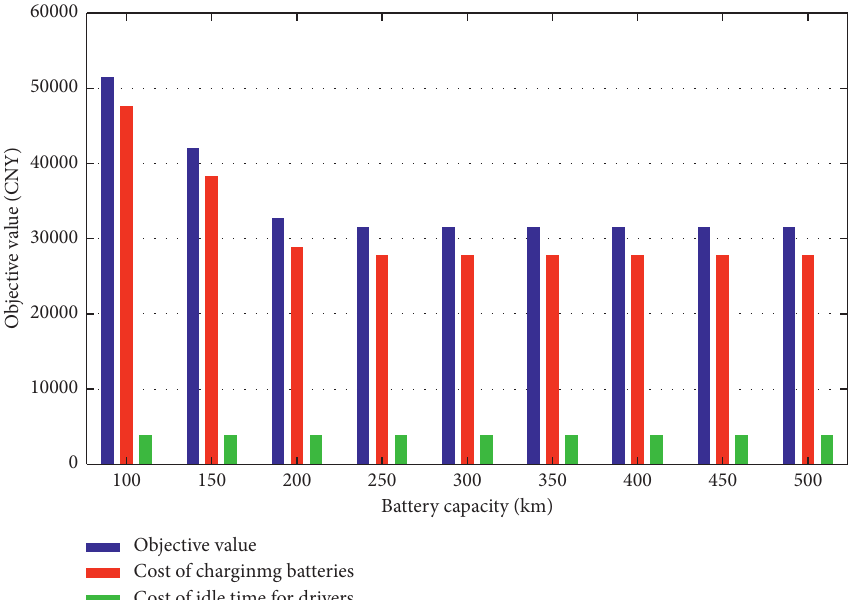
Figure 9: Effect of different battery capacities on the objective value.